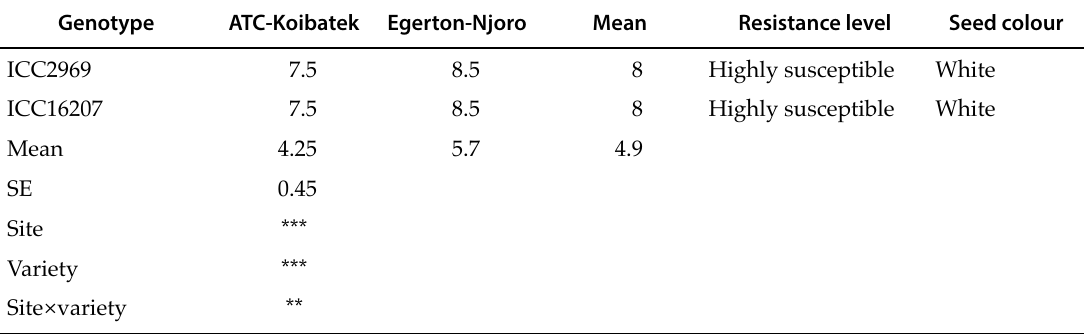
Table 1. Continues.